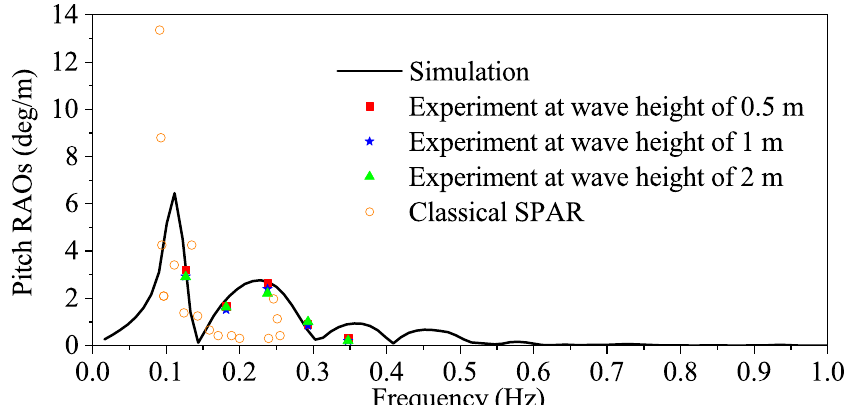
Figure 12. Pitch RAOs comparison between the simulation, experiments and a classical